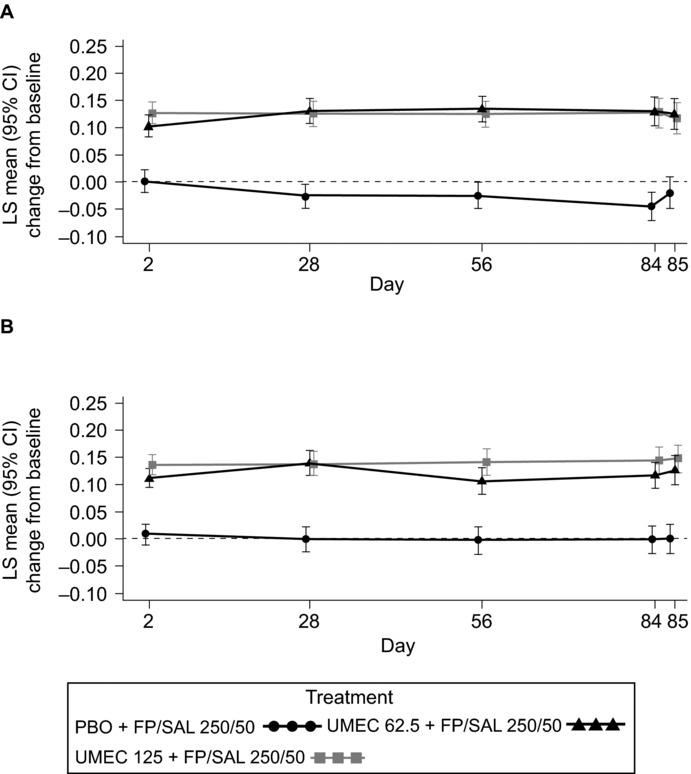

LS mean (95% CI) change from baseline in trough FEV1 (L) in Study 1 (A) and Study 2 (B) (ITT). CI, confidence interval; FEV1, forced expiratory volume in 1 second; FP/SAL, fluticasone propionate/salmeterol combination; ITT, intent-to-treat; LS, least squares; PBO, placebo; UMEC, umeclidinium. Analysis performed using a repeated measures model with covariates of treatment, baseline (mean of the two assessments made 30 minutes and 5 minutes pre-dose on Day 1), smoking status, Day, Day by baseline and Day by treatment interactions.